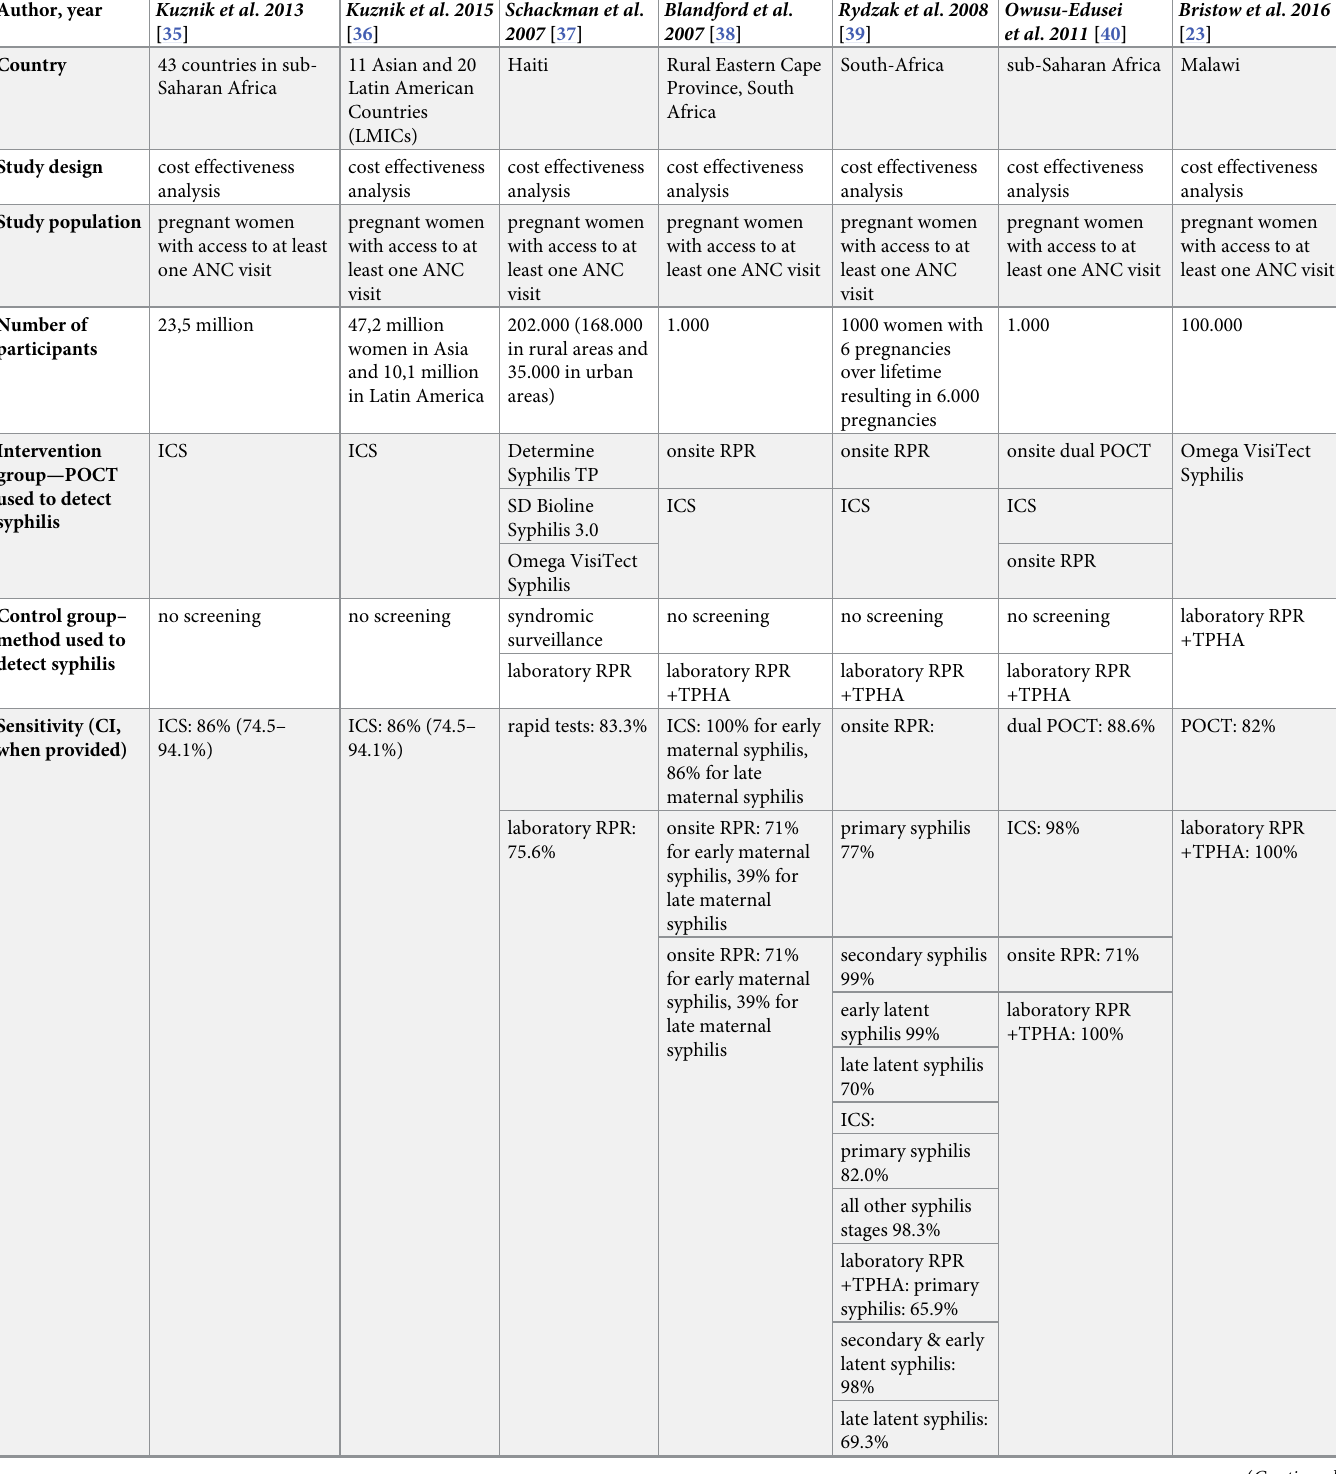
Table 3. Study characteristics in modelling